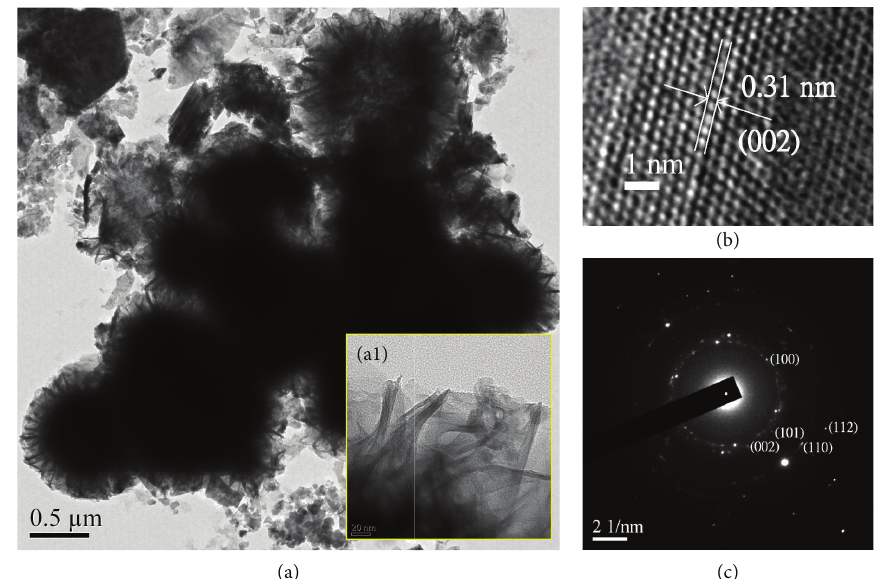
Figure 2: (a) HR-TEM images, (b) lattice fringes, and (c) the corresponding SAED pattern of 15N/ZnS.